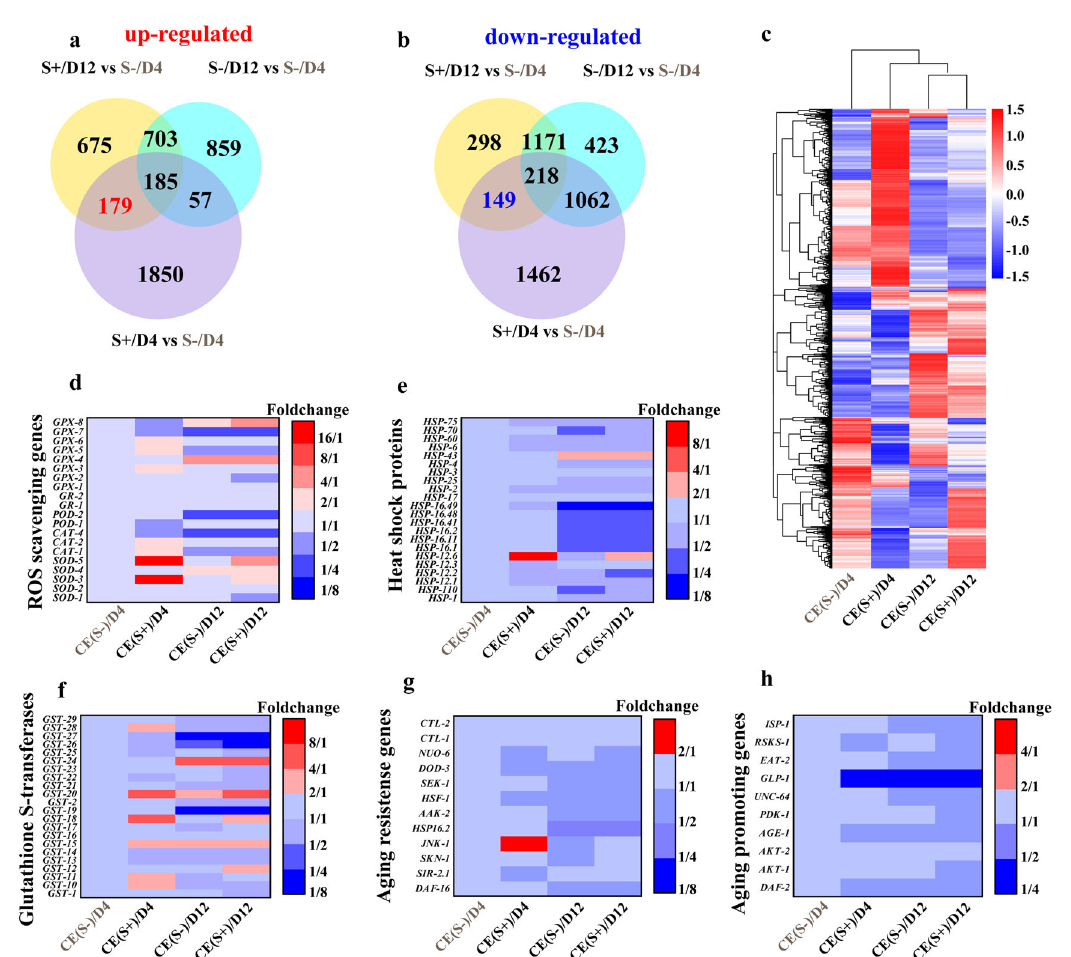
Fig. 5 Stress-response and aging-related genes regulated by PT-containing diet. a , b Venn diagrams of up- and down-regulated genes of the Caenorhabditis elegans , using S-/D4 as a reference for the other three groups of samples. c Fold-change heatmap of overall gene clustering. d – h Fold- change heatmaps of the genes for ROS-scavenging, heat-shock protein, glutathione S-transferase, age resistance and promotion for C. elegans , with reference to the C. elegans S-/D4